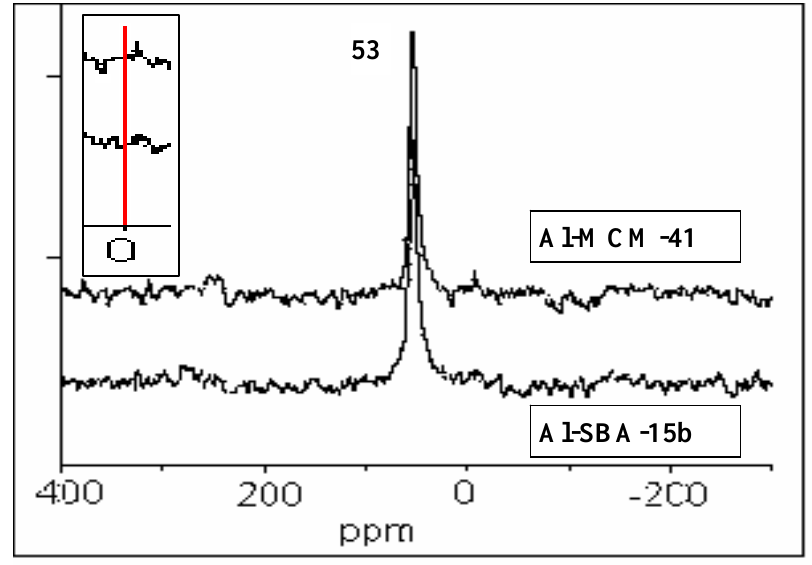
Figure 4. 27 Al MAS-NMR spectra of Al-MCM-41 and Al-SBA-15b.